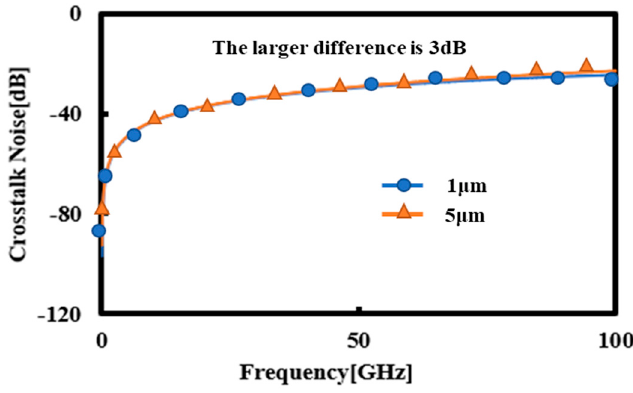
Figure 12. The crosstalk noise between two TSVs.